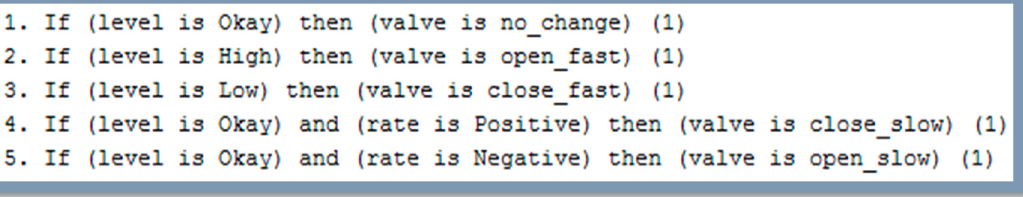
Figure 4. Fuzzy rules for the water tank controller.